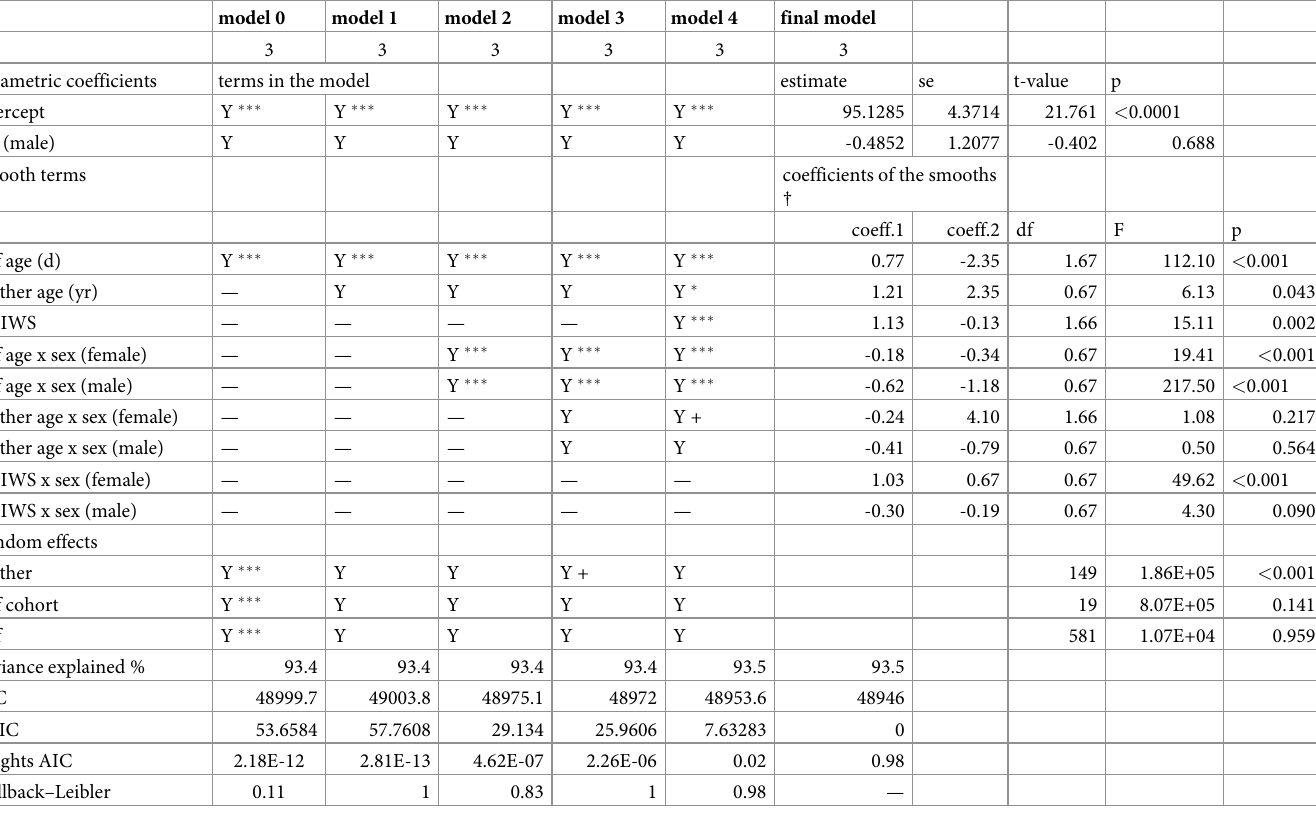
Table 5. Parametric, smooth coefficients and statistics of GAM models on red deer mother weight (Kg) together with animal and a thermal stress variable (THIWS). model